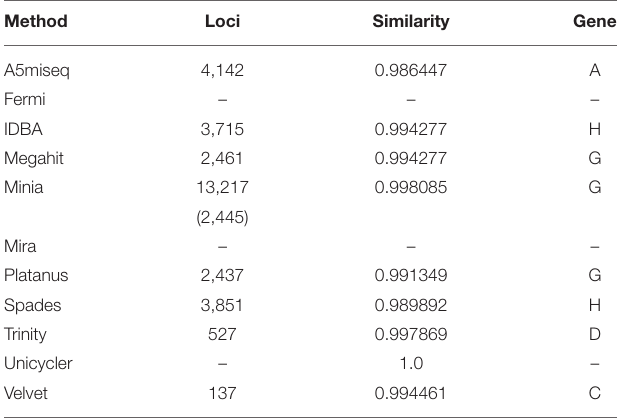
TABLE 3 | The starting location of defects and similarity to the reference for each consensus sequence.